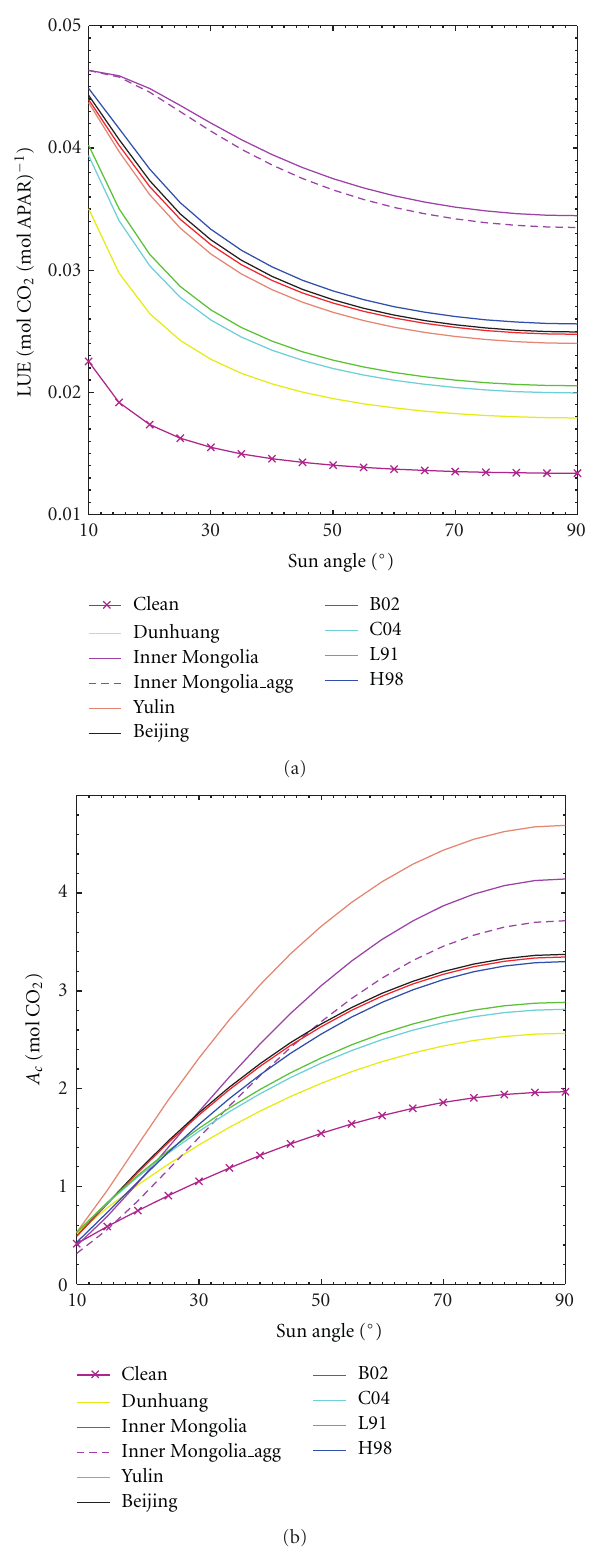
Figure 9: (a) Light use e ffi ciency (LUE), and (b) carbon assim- ilation rate ( A c ) computed with the Choudhury [34] model (for wheat) as a function of sun elevation angle. Dust loading M = 250 μ g m − 3 . Surface albedo is for the cropland-2 case.